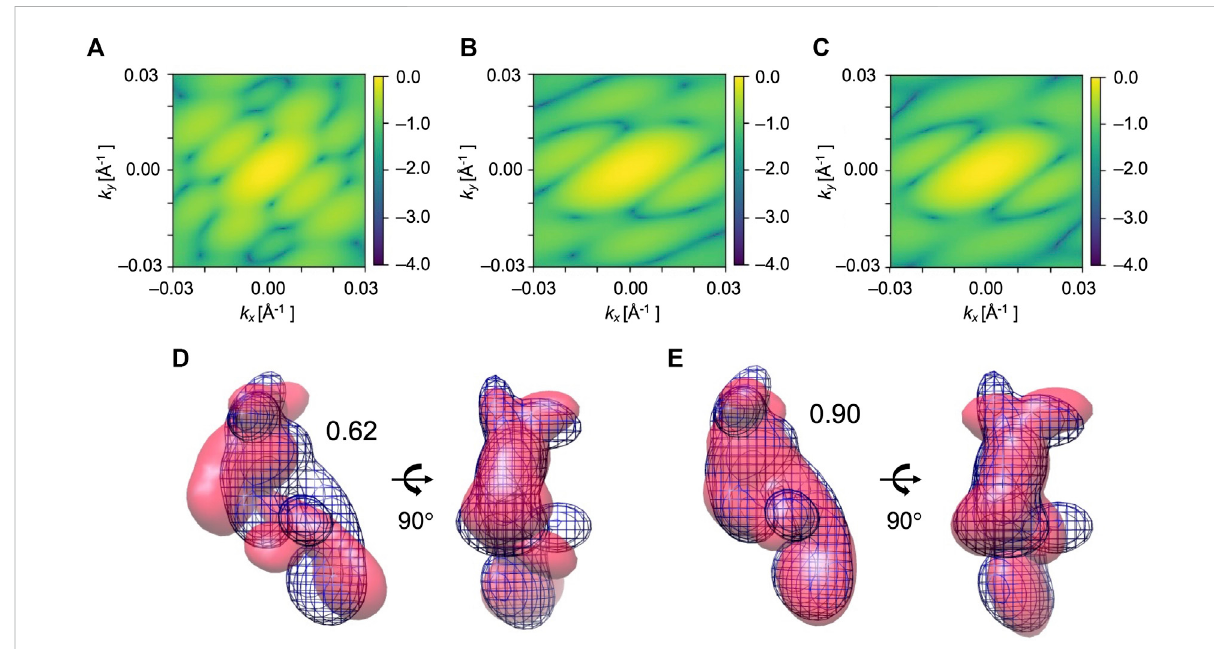
FIGURE 6 Simulated XFEL diffraction patterns from the initial (A) , candidate (B) , and target (C) GMM models from the fi tting of EF2. k x and k y represent the wavenumbers of diffraction vectors (without 2 π ). Initial 2D CC between (A) and (C) was 0.09, which increased to 0.97 between the (B) and (C) after the MC simulation process. GMM representations of EF2 before and after the fi tting are shown. (D) The initial model is in pink, the reference GMM representation of the target model is in blue mesh. Initial 3D CC between the initial model and target is 0.62. (E) The candidate model is in pink, the reference GMM representation of the target model is in blue mesh. The fi nal 3D CC between the candidate model and target is 0.90.